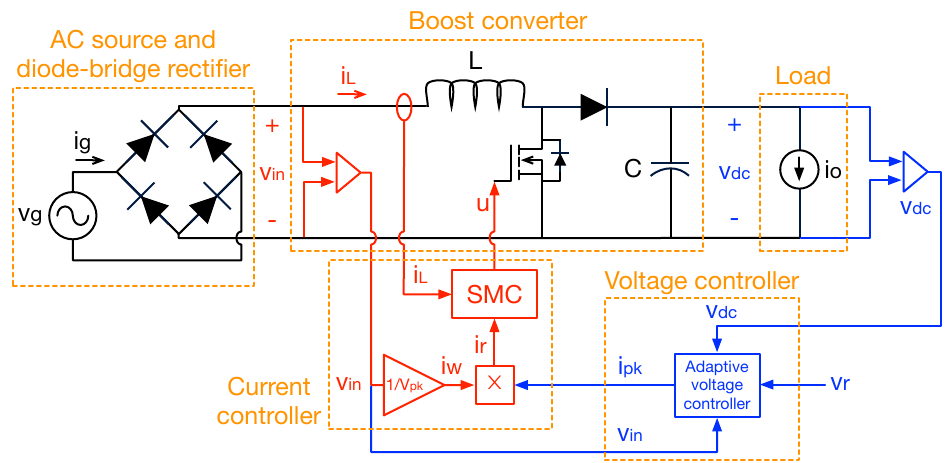
Figure 1. Electrical scheme of the Boost-based rectifier with power factor